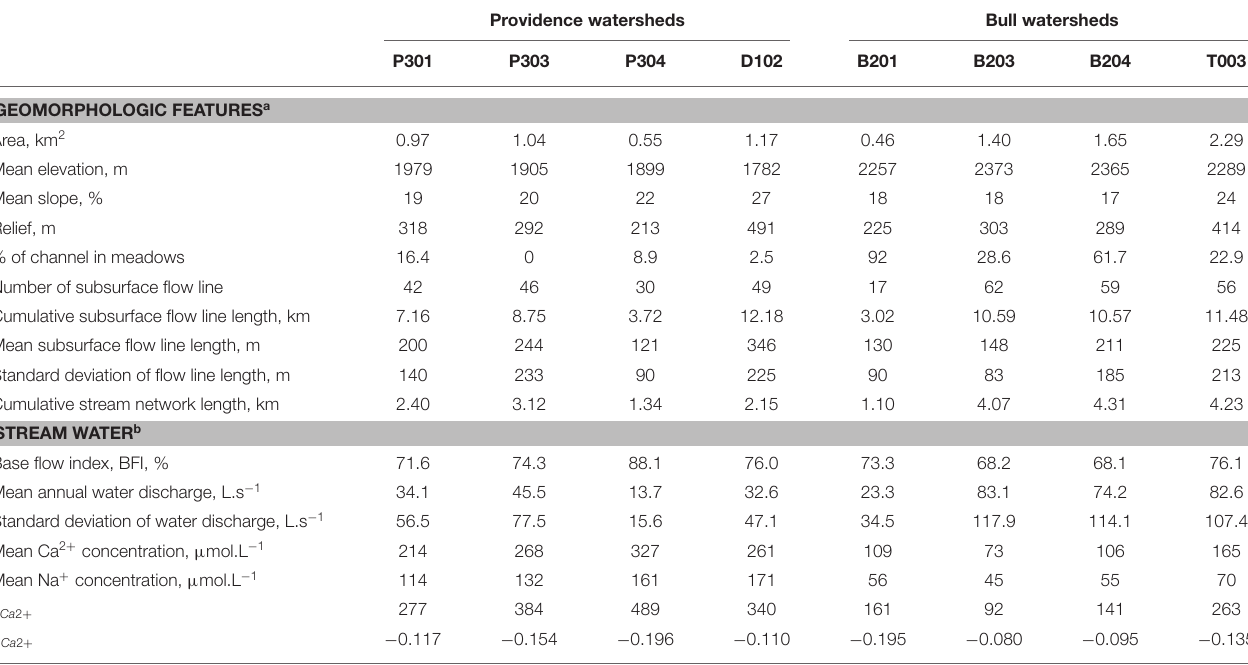
TABLE 2 | Main geomorphologic features and stream water chemistry